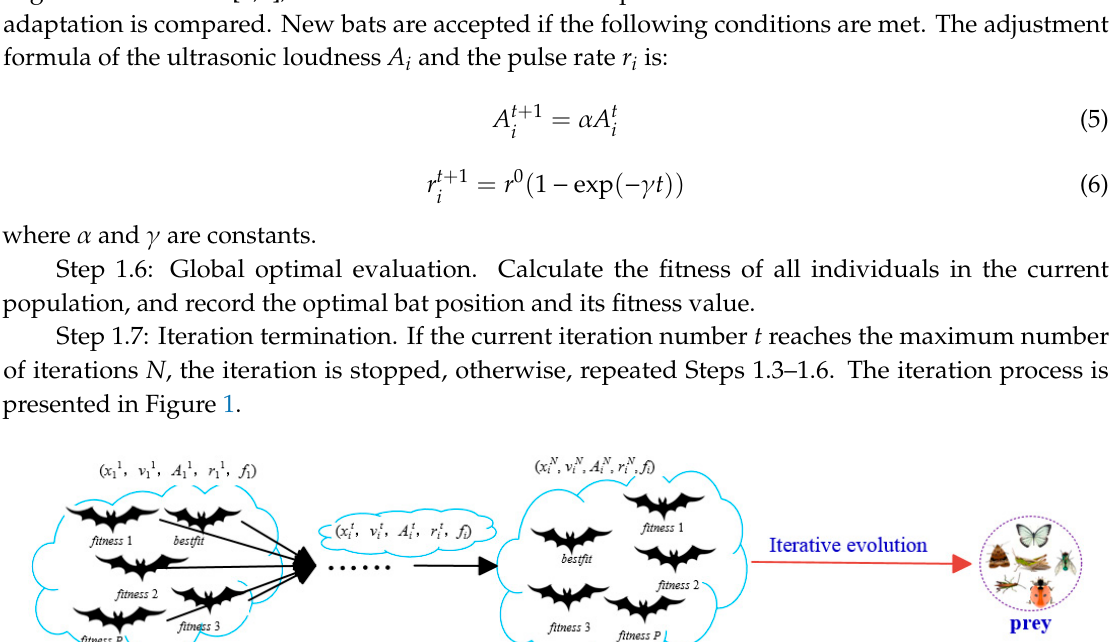
Figure 1. Foraging process of the bat.